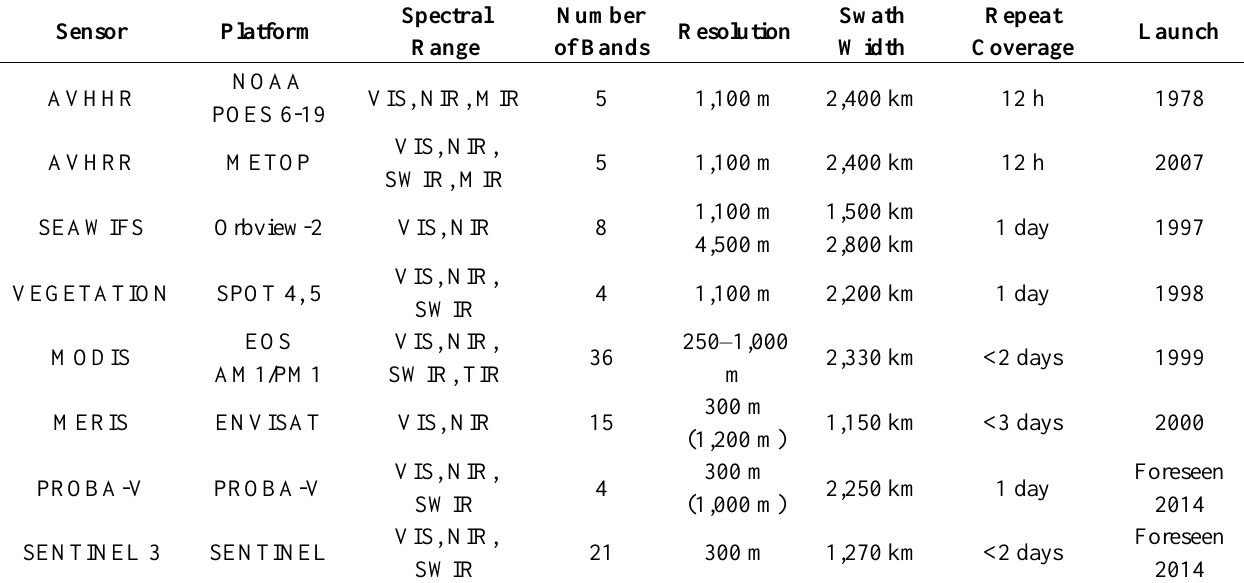
Table 1. Properties of the most common optical low and medium resolution operational and planned sensors relevant for vegetation monitoring. (The following abbreviations are used for different intervals of the electromagnetic spectrum: VIS = visible, NIR = near infrared, SWIR = short wave infrared, MIR = medium infrared). NB: The ENVISAT mission stopped officially in May